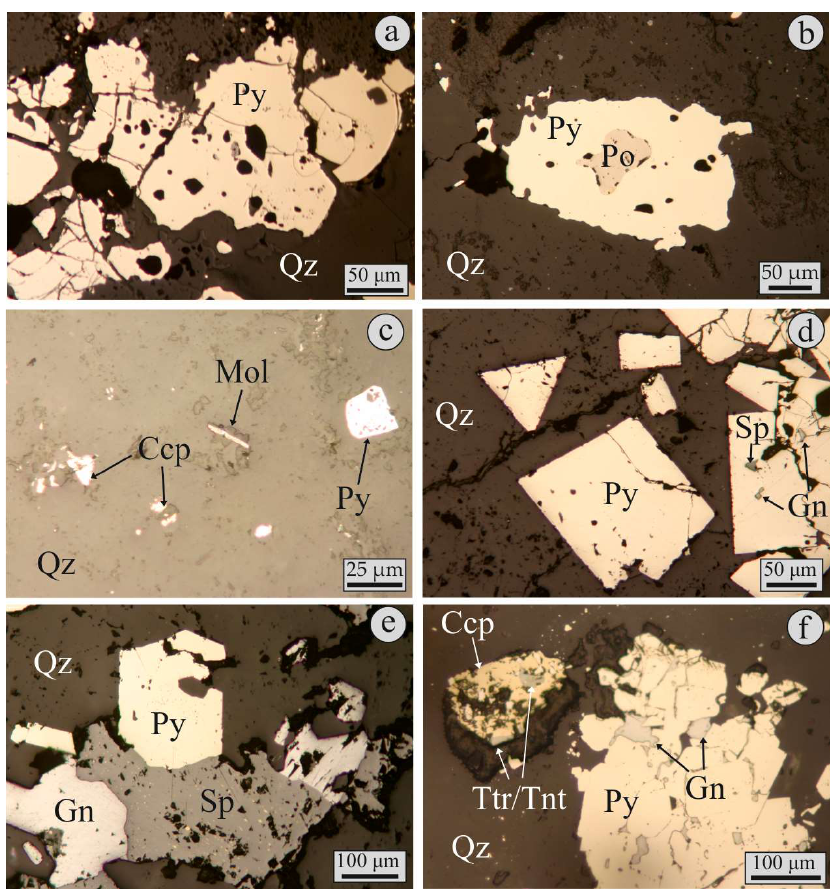
Figure 4. Reflected light photomicrographs of pyrite and associated opaque minerals from different stages mineralization in the Konos Hill porphyry-epithermal prospect. ( a ) Anhedral, “corroded” pyrite (py) grains in quartz (Qz), from a D-type vein (Sample KMSP64); ( b ) Anhedral, “corroded” pyrite grain including pyrrhotite (Po), D-type vein (Sample KMSP64; ( c ) Disseminated molybdenite (Mol) in association with chalcopyrite (Ccp) and pyrite (Py) in quartz (Qz), D-type vein, (Sample KMSP64); ( d ) Euhedral pyrite (py) in quartz (Qz) that includes blebs of sphalerite (Sp) and galena (Gn), epithermal-style vein, (sample KMSP48); ( e ) Euhedral pyrite (py) associated with galena (Gn) and sphalerite (Sp), the latter displaying “chalcopyrite disease”, within quartz (Qz), E-type vein (KMSP48); ( f ) Euhedral pyrite rimmed by and including galena (Gn), in association with an intergrowth of chalcopyrite (Ccp) and tetrahedrite-tennantite group mineral (Ttr/Tnt), included in quartz (Qz), E-type vein (KMSP48).